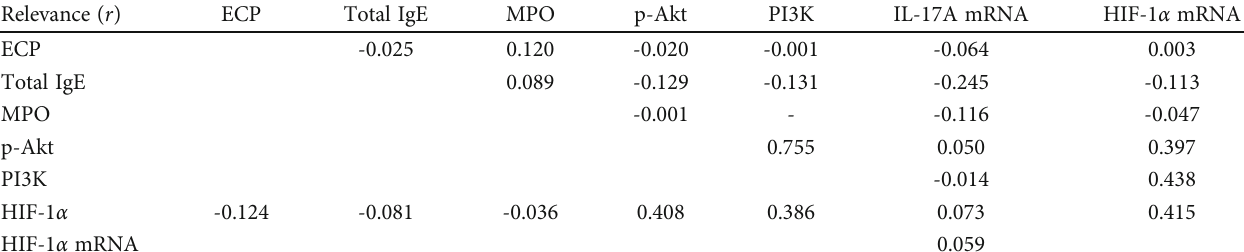
Table 1: Correlations among tissue indicators in CRSwNP patients.